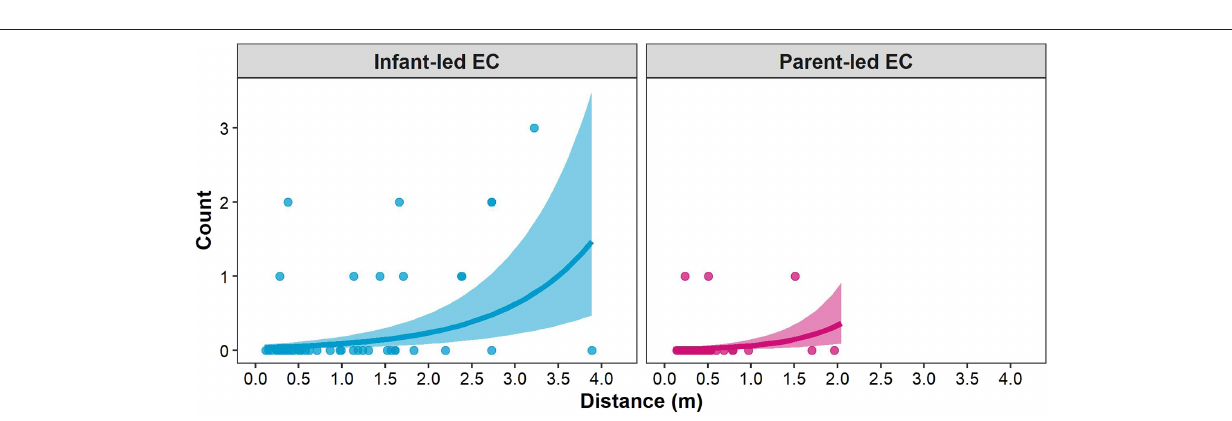
FIGURE 4 | Relationship between the infant-parent distance and number of objects on the floor between the dyad for infant-led EC bouts (left panel; cyan) and parent-led EC bouts (right panel; magenta) on one observation day of one infant (when infant A was 15.5 months of age). The posterior mean (colored lines) and 95% credible interval (colored areas) of the mean number of objects between the dyad are shown. The colored dots represent the observed